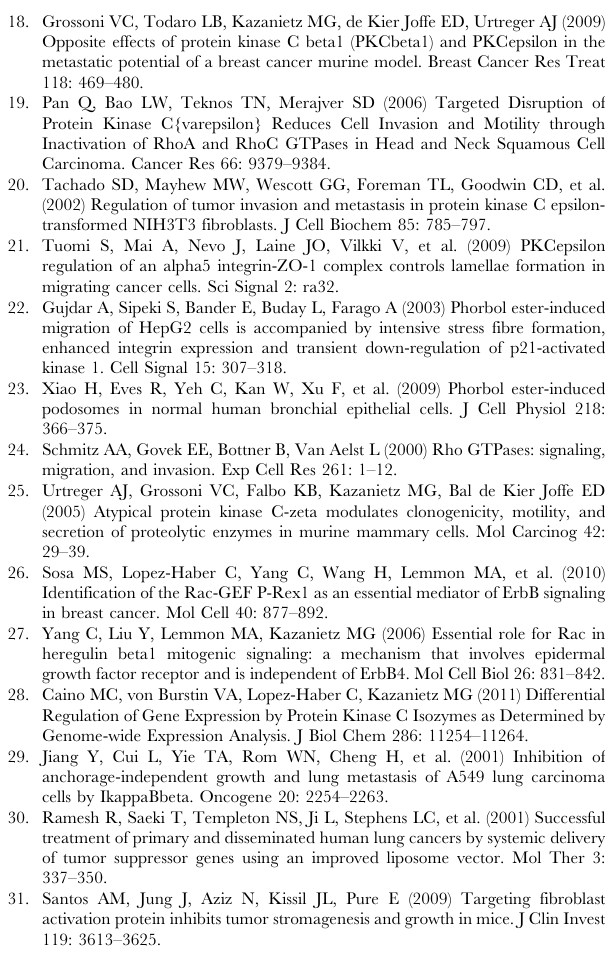
(5 m M). FBS (10%) was added to the lower compartment. Migratory cells were determined 16 h later. Left panel , represen- tative experiments. Right panel , quantification of migratory cells. Figure S6 PKC e overexpression enhances wound clo- sure induced by serum in NSCLC cells. Cells were infected with adenovirus (AdV) coding the indicated proteins, serum starved for 24 h and assayed for migration in response to serum (FBS) with either wound assays or Boyden chambers. Cells were infected with a control (LacZ) or PKC AdVs at multiplicities of infection = 100 pfu/cell. A) Expression of PKC isozymes at the day of the experiment. B) Representative micrographs for a wound assay in A549 infected with LacZAdV or PKC e AdV. C) Quantification of wound closure induced by 10% FBS for H358 or A549 cells infected with LacZ, PKC a , PKC d or PKC e AdVs. Data are expressed as mean 6 S.E.M. (n= 3). *, p , 0.05; **, p , 0.01; ***, p , 0.001. (TIF) Figure S7 e V1-2 concentration-response in migration assays. H358 cells were seeded in Boyden chambers in the presence of TAT 10 m M or e V1-2 (0.1–10 m M). FBS (10%) was added to the lower compartment. Migratory cells were measured at 16 h. Left panel , representative experiments. Right panel ,